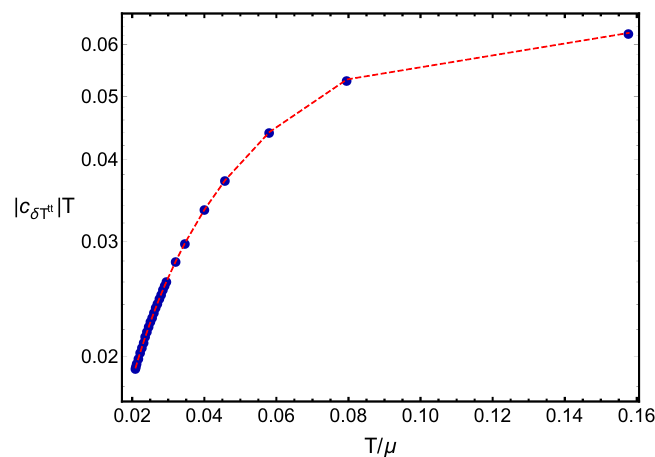
(eq. (C.5)) of the δT tt fluctuations to the incoherent current ˜ v Figure 13 . The contribution c δT tt The blue points are numerically extracted by inverting the matrix of the amplitudes of the different modes presented in the main text as in eq. (C.4). The red dashed line is the analytic result ρT